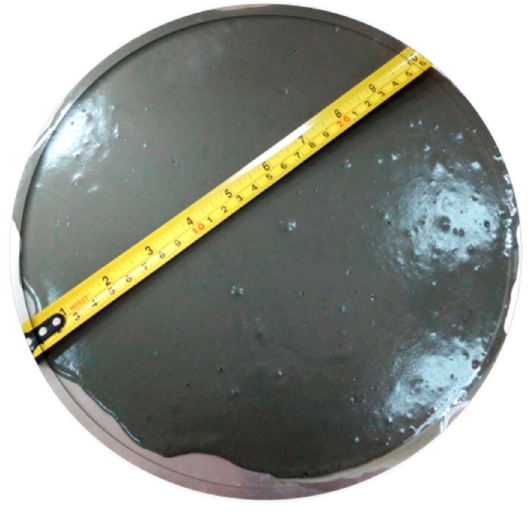
Figure 4. Flow test of concrete Mix Figure 4 . Flow test of concrete Mix 1 .